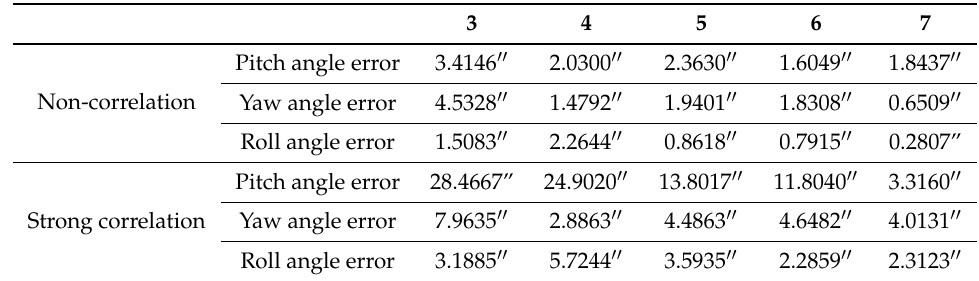
Table 1. The effect of the number and correlation of landmarks on the accuracy of the transformation